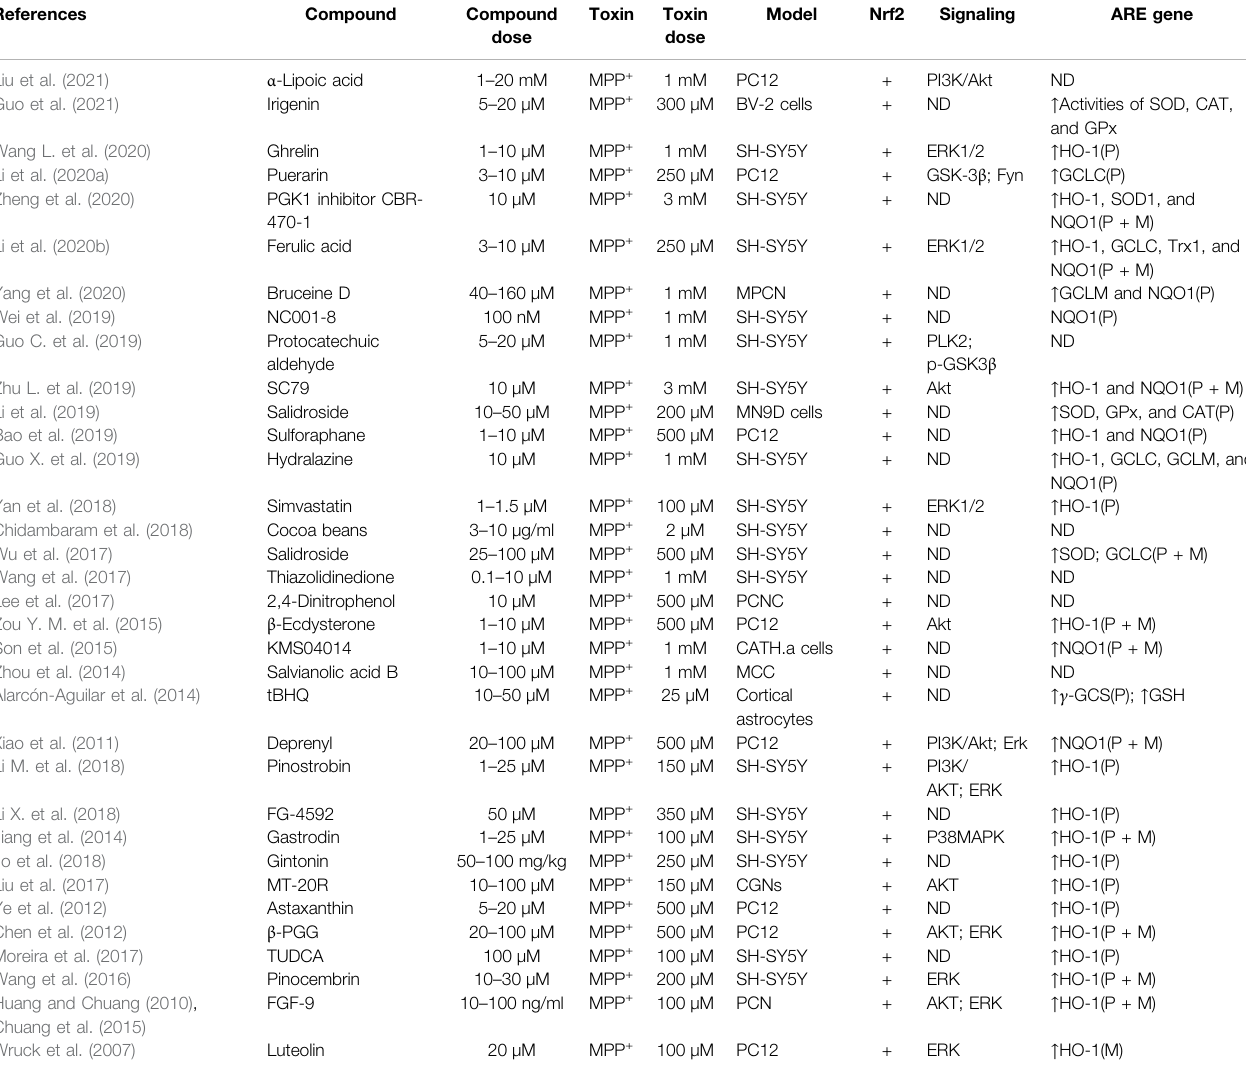
TABLE 3 | Summary of the experimental studies involving compounds able to modulate Nrf2 pathway in MPP + -induced PD